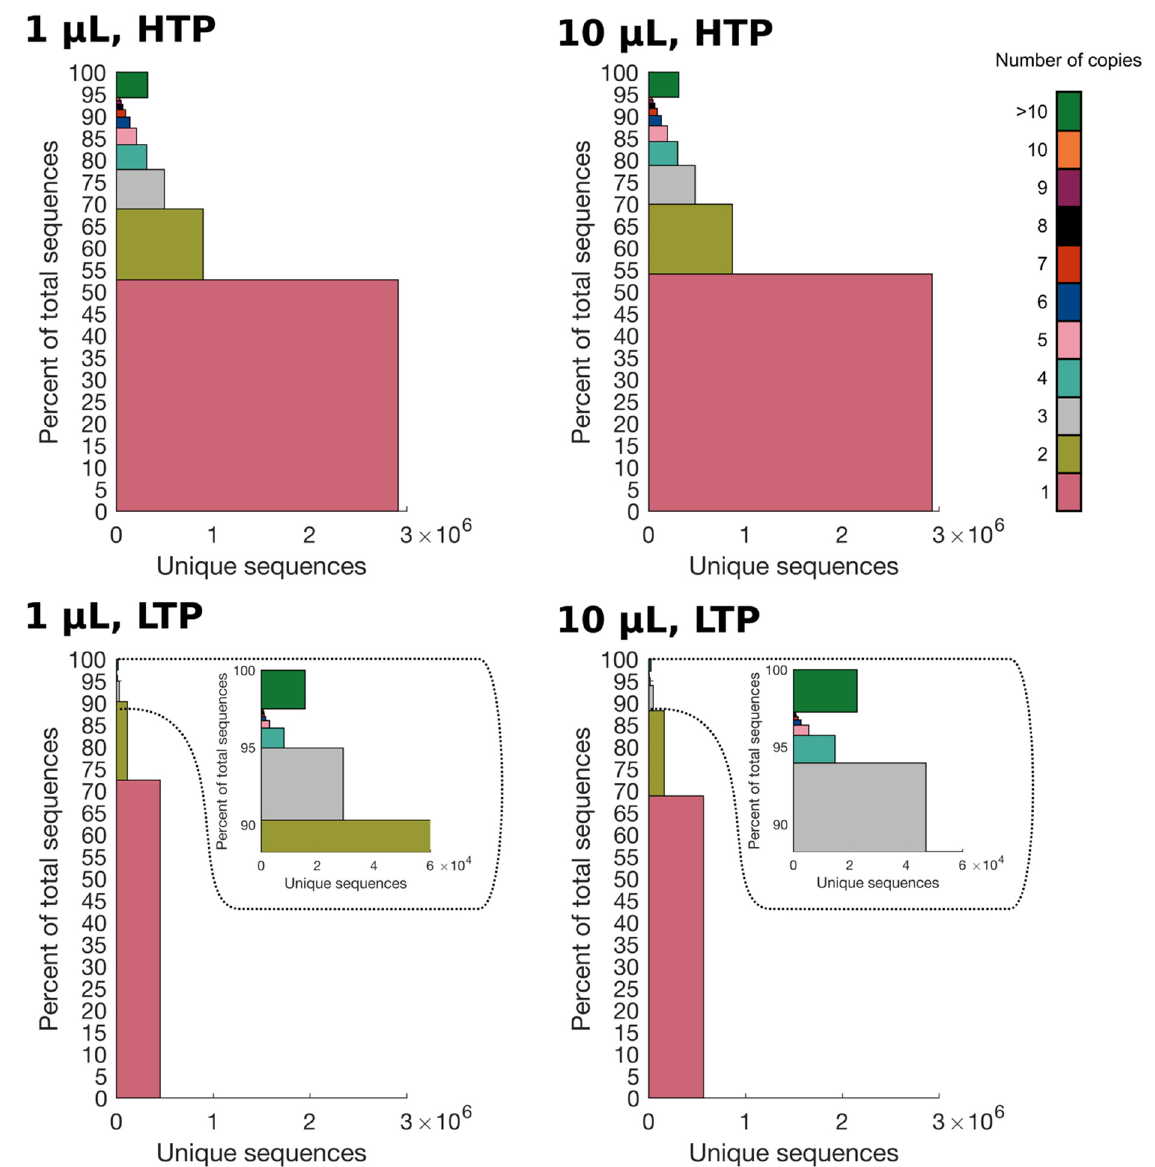
Figure 1. Stacked bar plot for HTP datasets (1 μ L and 10 μ L) and LTP datasets (1 μ L and 10 μ L). The datasets were grouped into color ‐ coded populations according to the absolute frequency of peptide sequences (see color key). For each population, the sum of abundances is shown as the height for each segment, whereas the width corresponds to the number of unique sequences in each segment. Chi ‐ square test with Yates correction proved the difference between the singleton populations to be statistically significant for all four samples (p < 0.0001).